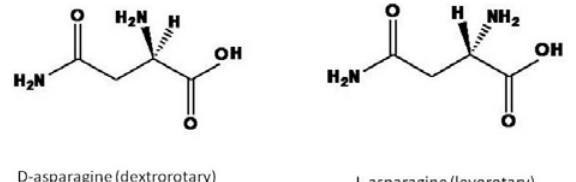
Figure 2. The two forms of